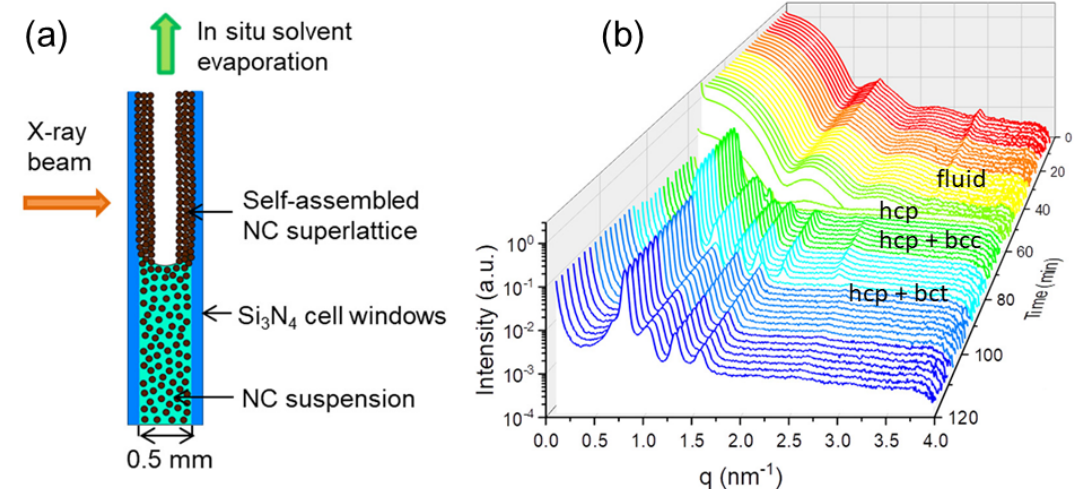
Figure 11. Evaporation-induced self-assembly of faceted PbS nanocrystals (NC). ( a ) Schematic view of the sample cell used for in situ measurements during controlled evaporation. ( b ) Time evolution of the SAXS profiles during the controlled solvent (heptane) evaporation from a 10 mg/mL colloidal suspension of nanocrystals. From the initial fluid-like colloidal solution, different crystalline morphologies, such as hcp, in coexistence with bcc and bct emerged as a function of evaporation time. The high angle peak in the fluid state is from the oleic acid grafting layer on nanocrystals. Adapted from I. Lokteva et al. [98] with permission from the American Chemical Society, c